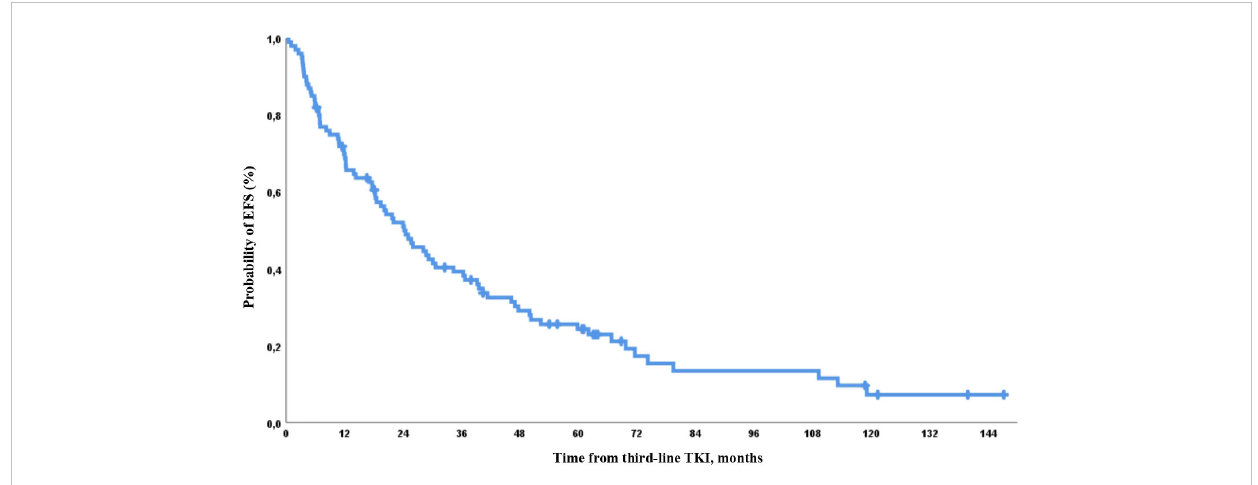
FIGURE 9 EFS on third-line therapy in the whole group.